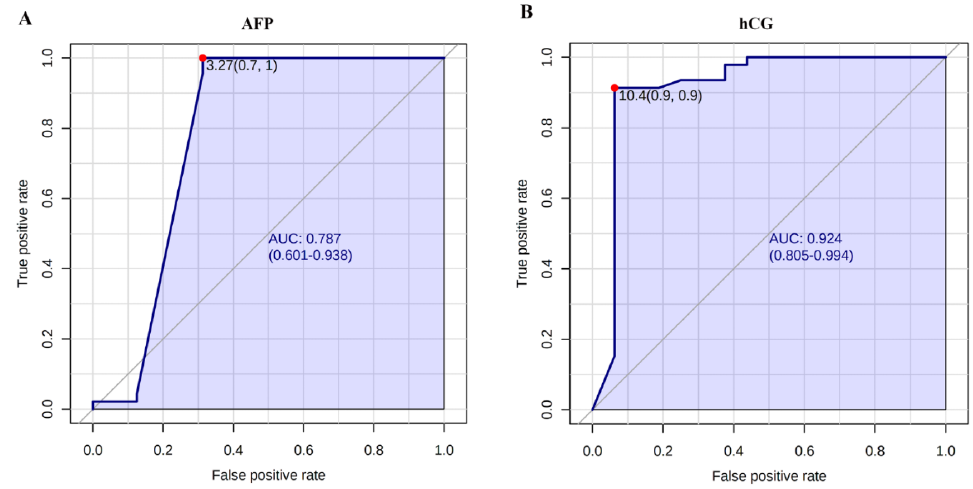
Figure 3. Receiver operating characteristic (ROC) analysis of cerebrospinal fluid (CSF) levels of ( A ): alpha-fetoprotein (AFP) and ( B ): human chorionic gonadotropin (hCG) in patients affected by non-germinomatous germ cells tumors (NGGCT)